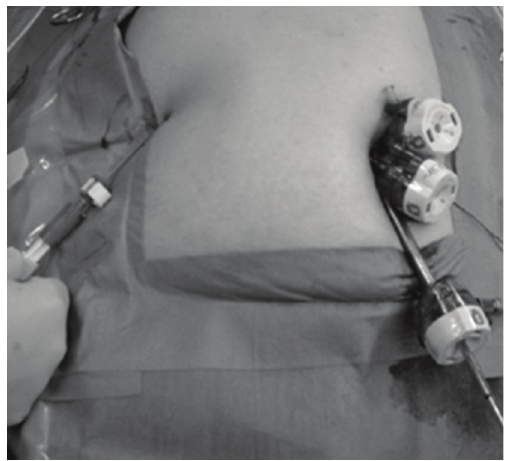
Figure 2: External view of 3-port LC via umbilical